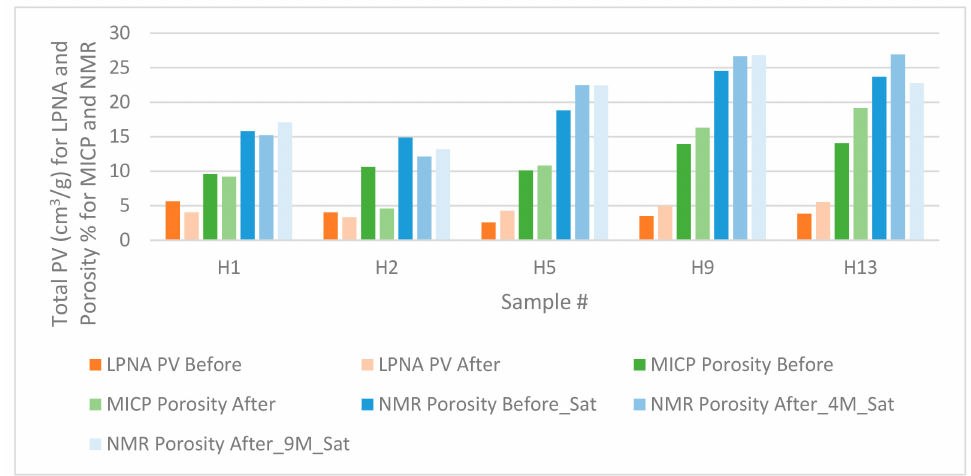
Figure 14. Porosity results from low-pressure nitrogen adsorption (LPNA), mercury injection capillary pressure (MICP), and NMR-Sat methods. LPNA pore volume values are in cm 3 / g, and MICP and NMR values are porosity in